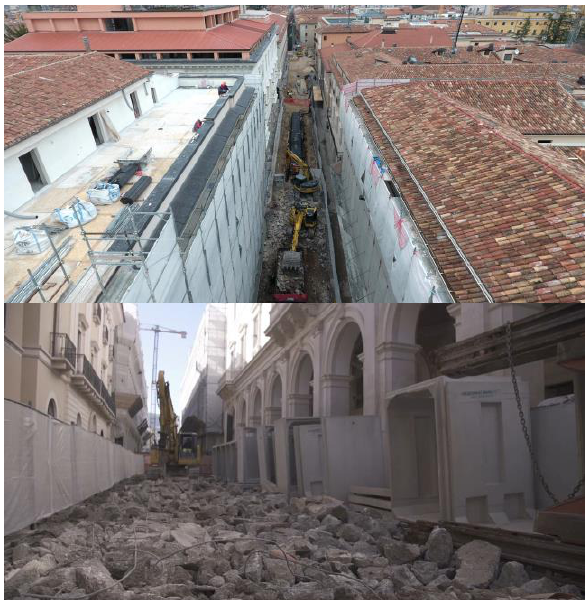
Figure 8. Photos of Corso Vittorio Emanuele, one of the main access roads to the L’Aquila historical centre, that is